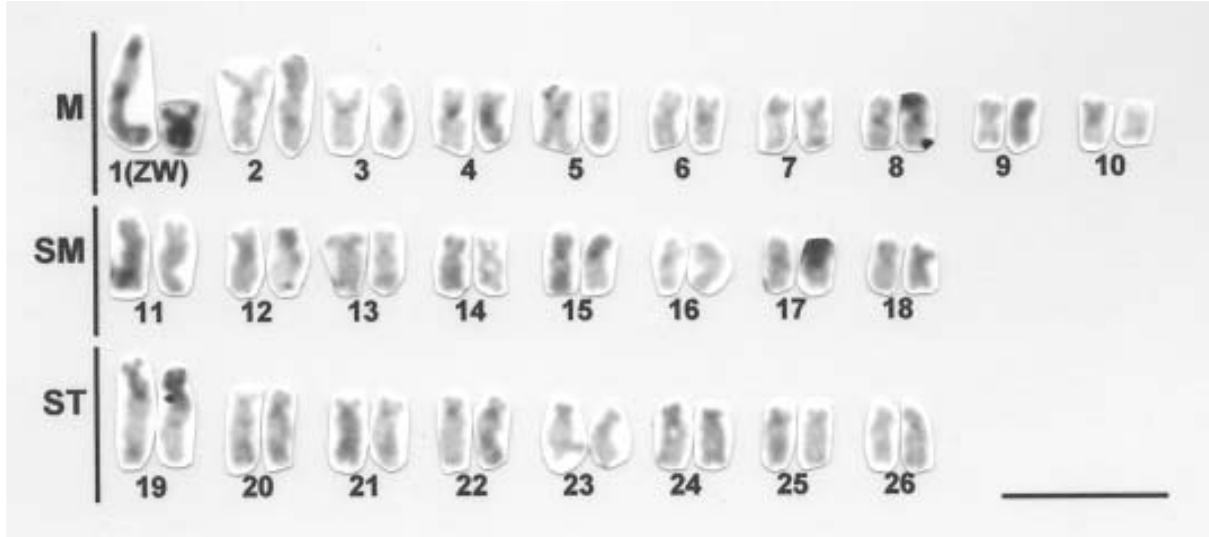
Figure 2 - C-banded karyotype of a female Triportheus venezuelensis . Bar = 10 μ m.